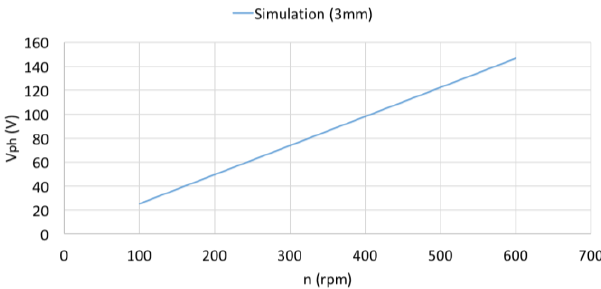
Figure 4. Plot versus the speed of the Back-EMF, RMS, with 3 mm air gaps, simulation results.